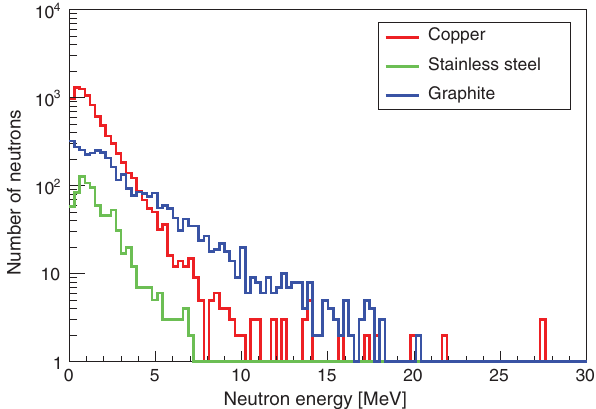
FIG. 13. Neutrons generated when a beam with 10 7 electrons at 75 MeV electrons collides with copper, stainless steal and